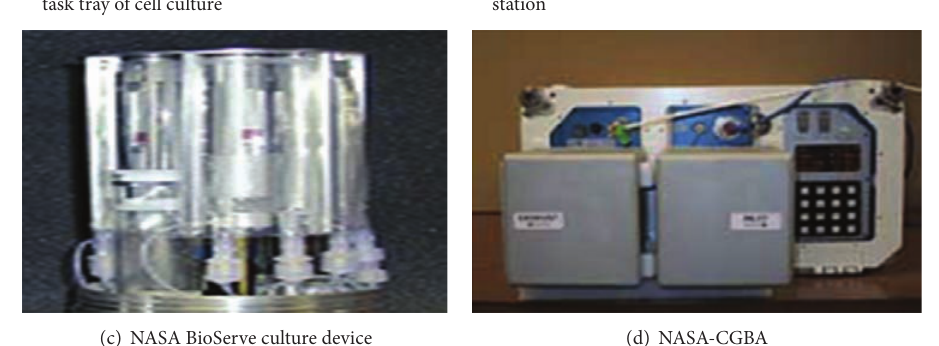
Figure 1: Successful applications of space cell culture instruments.